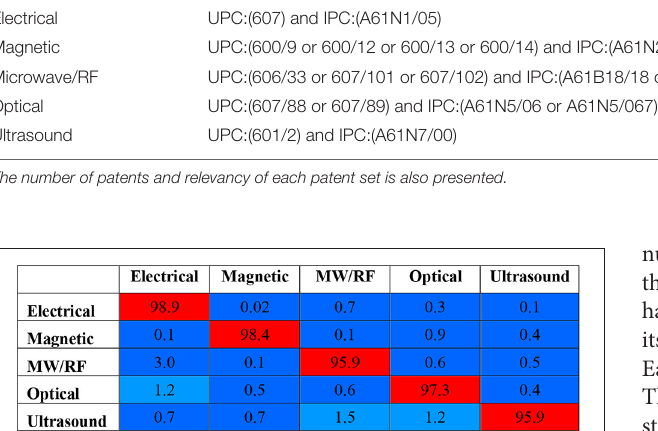
TABLE 1 | Energy-based therapeutic technological domains with the respective UPC and IPC classes used for obtaining patents between 1970 and 2015, using the COM method. Therapeutic Domains